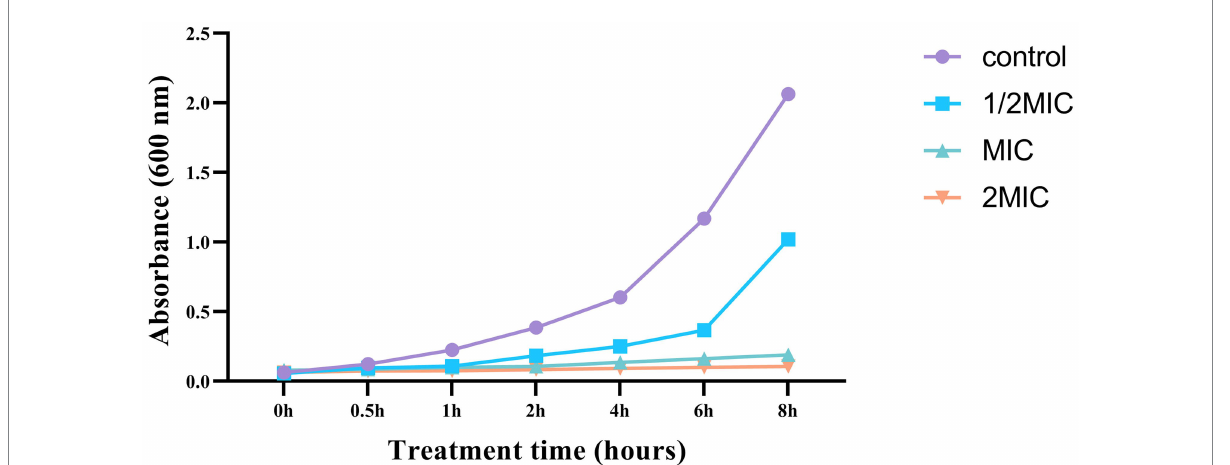
FIGURE 5 The growth curve of P. carotovorum under different concentrations of Mf-AgNP.